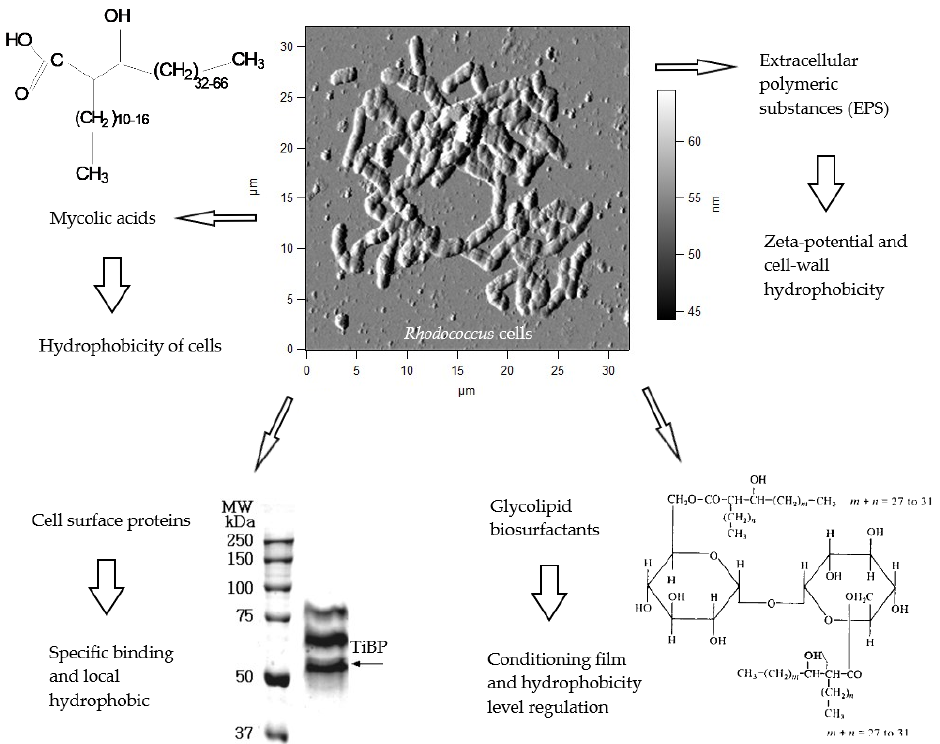
Figure 2. Key biomolecules participating in Rhodococcus cell adhesion to solid carriers and mechanisms of their action. An atomic force microscope image of Rhodococcus cells (the authors’ original data, unpublished) is in the centre. A SDS-PAGE electrophoregram of a titanium-binding protein TiBP and a trehalose-dicorynomycolate structural formula are cited from reference [112] and reference [45],